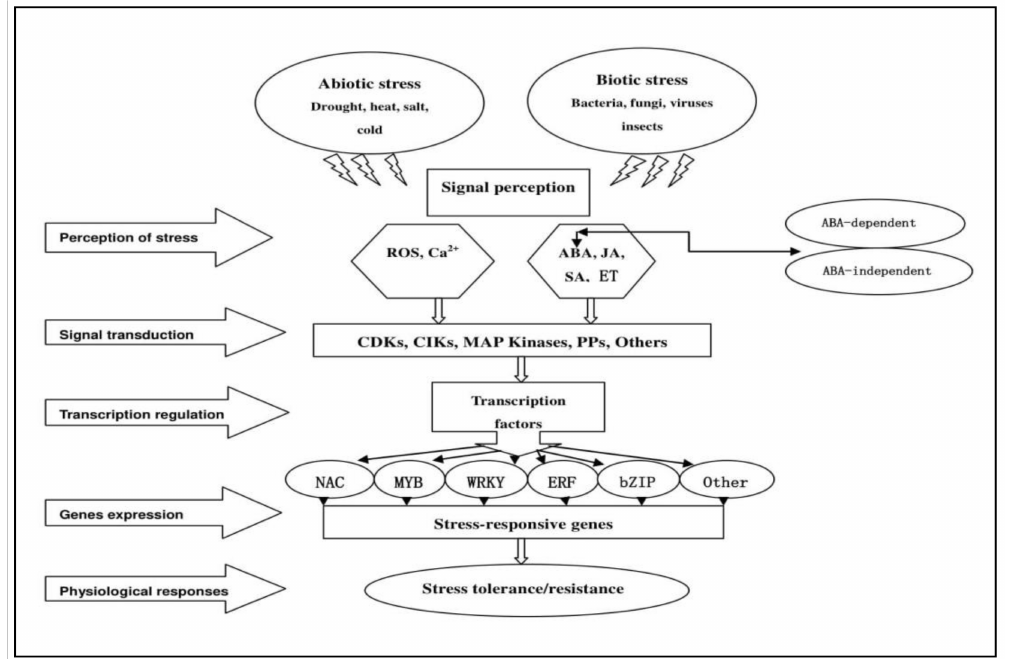
Figure 2. A schematic model of the signaling pathways involved in abiotic and biotic stress